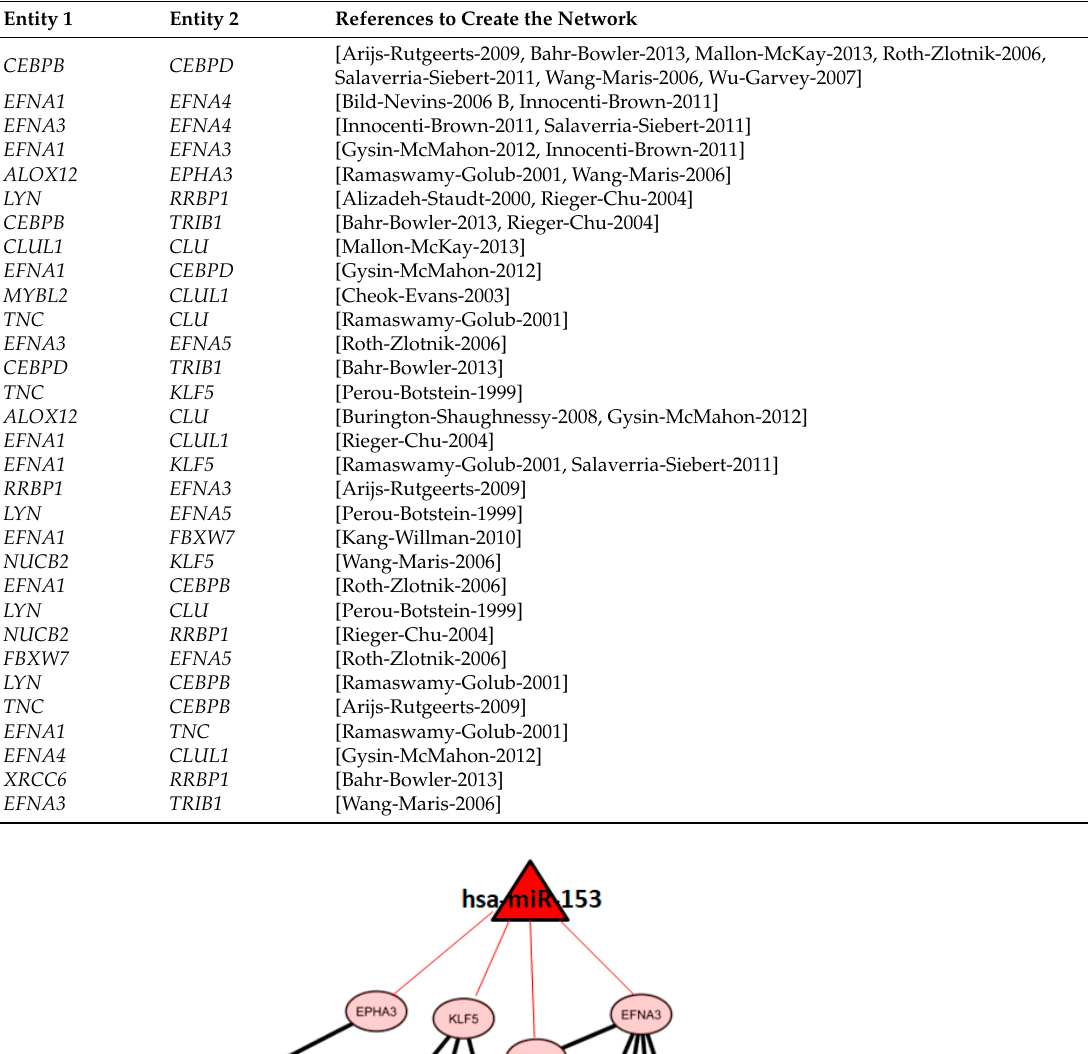
Table 4. Gene co-expression from GeneMania.